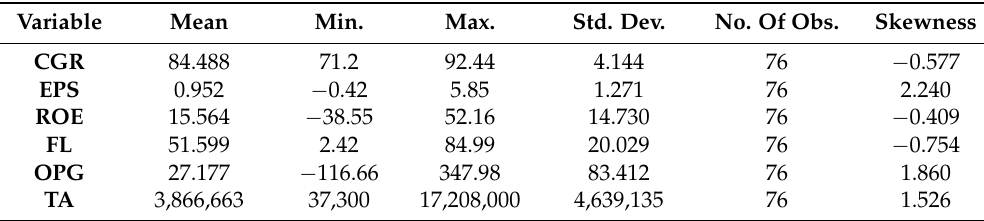
Table 2. Descriptive